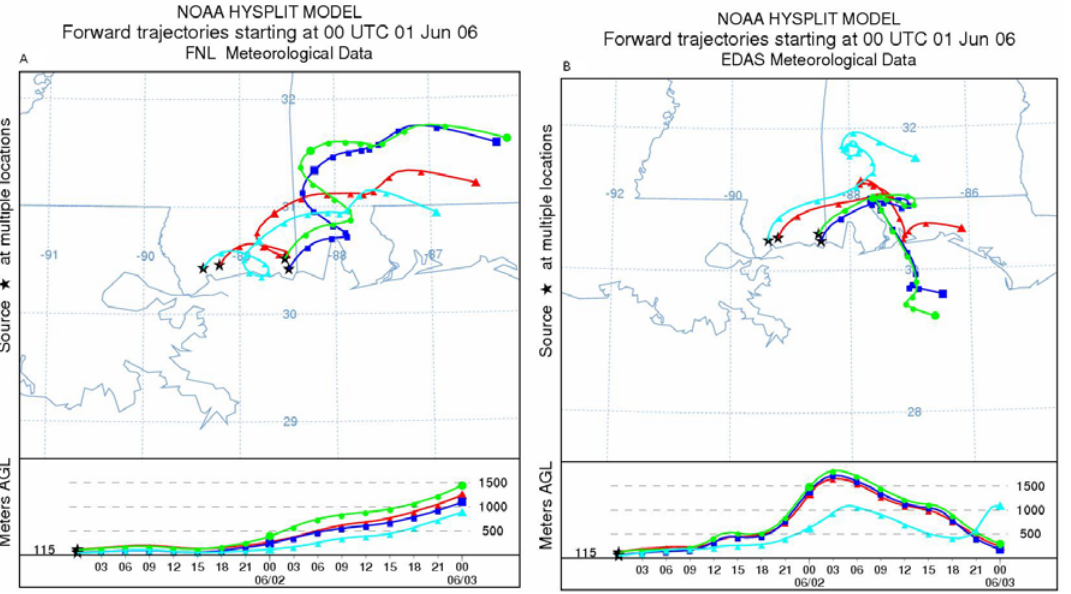
Figure 6. Forward trajectories from the source regions with FNL analysis (a), Eta AWIP analysis (b) and WRF model outputs